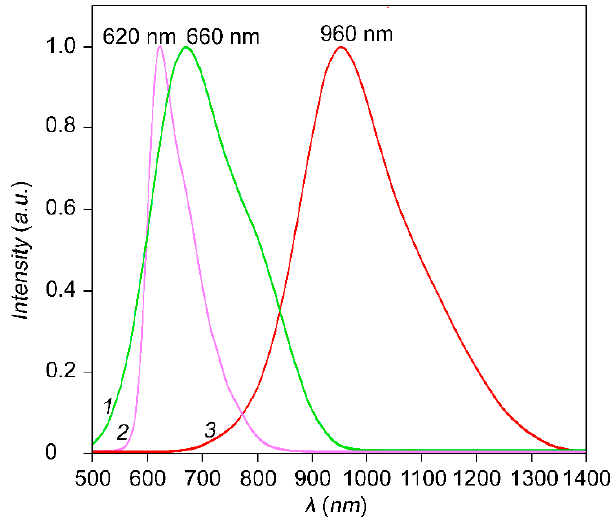
Figure 3. Luminescence spectra of Ag 2 S QDs colloidal solutions. The maxima of luminescence bands are at 660 nm, 620 nm, and 950 nm for Ag 2 S QDs with average size of 1.8 nm, 2.0 nm and 3.2 nm